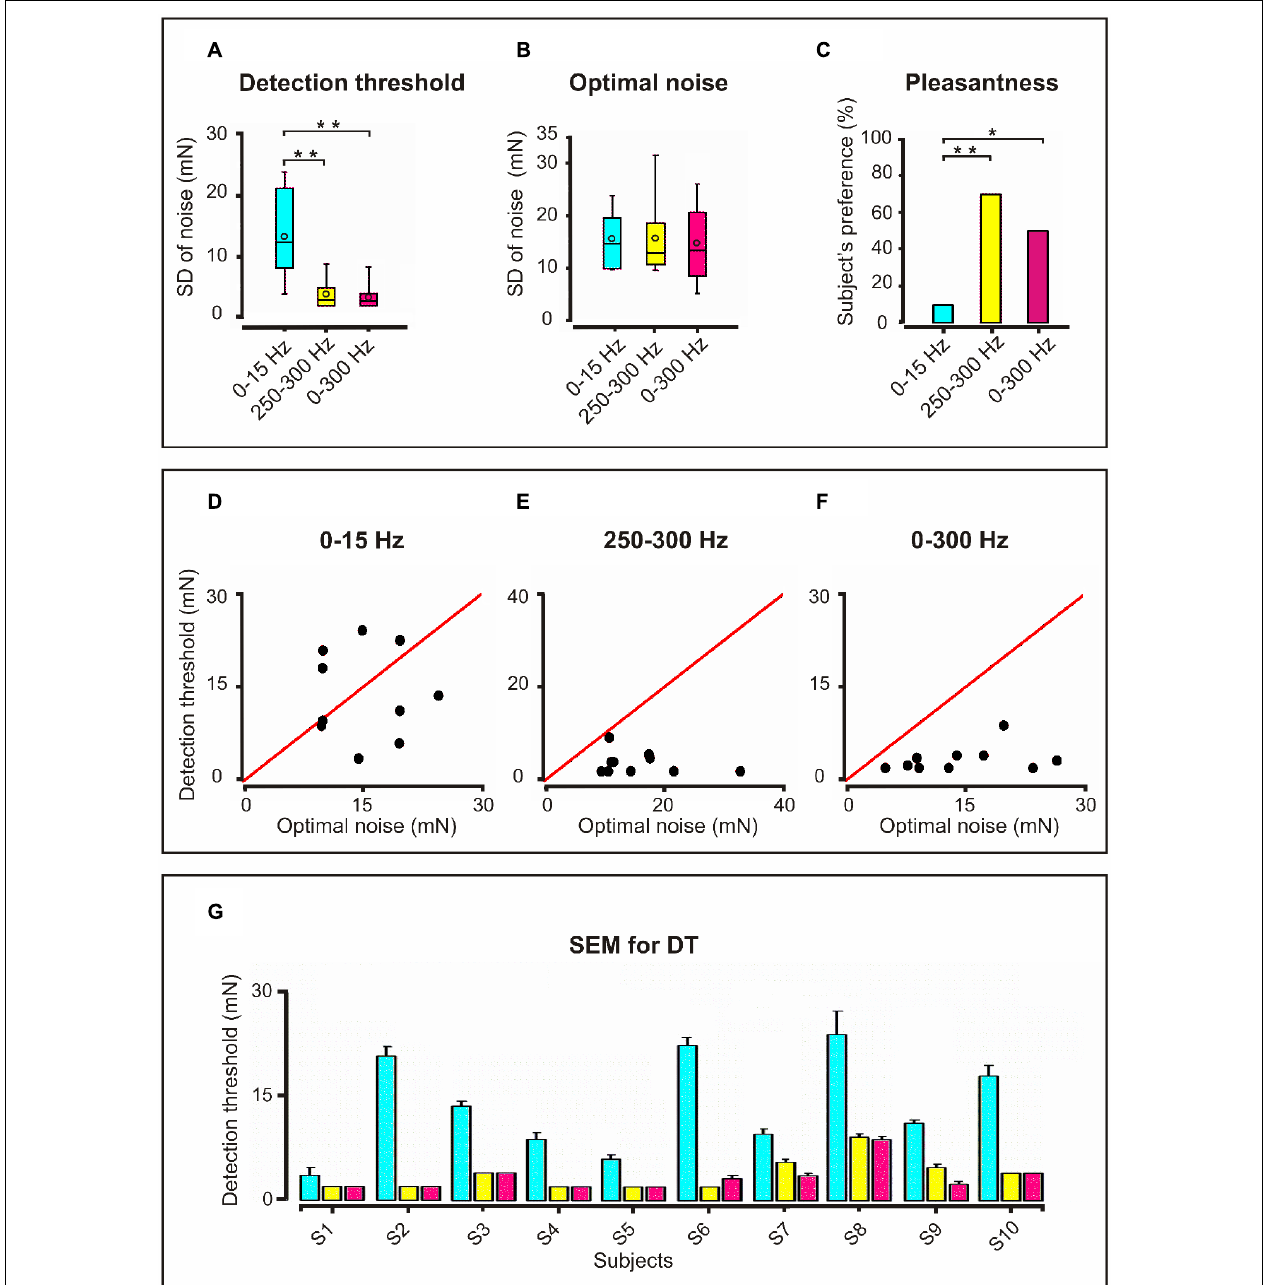
FIGURE 2 | Detection threshold, optimal noise and pleasantness for the three frequency bandwidths: Upper panel (A) Detection threshold in box plots with interquartile range displayed as the length of the box, with the median as a line inside the box and the minimal and maximal values as vertical lines. Mean values shown as small unfilled circles within the boxplots. Higher detection threshold for 0–15 Hz compared to 250–300 Hz and 0–300 Hz bandwidths (** p = 0.002). (B) Boxplots for optimal noise showing similar noise levels for the three frequency bandwidths. (C) Higher degree of subjective pleasantness (percentage) for the 250–300 Hz and 0–300 Hz than for the 0–15 Hz noise bandwidth. * p = 0.02;